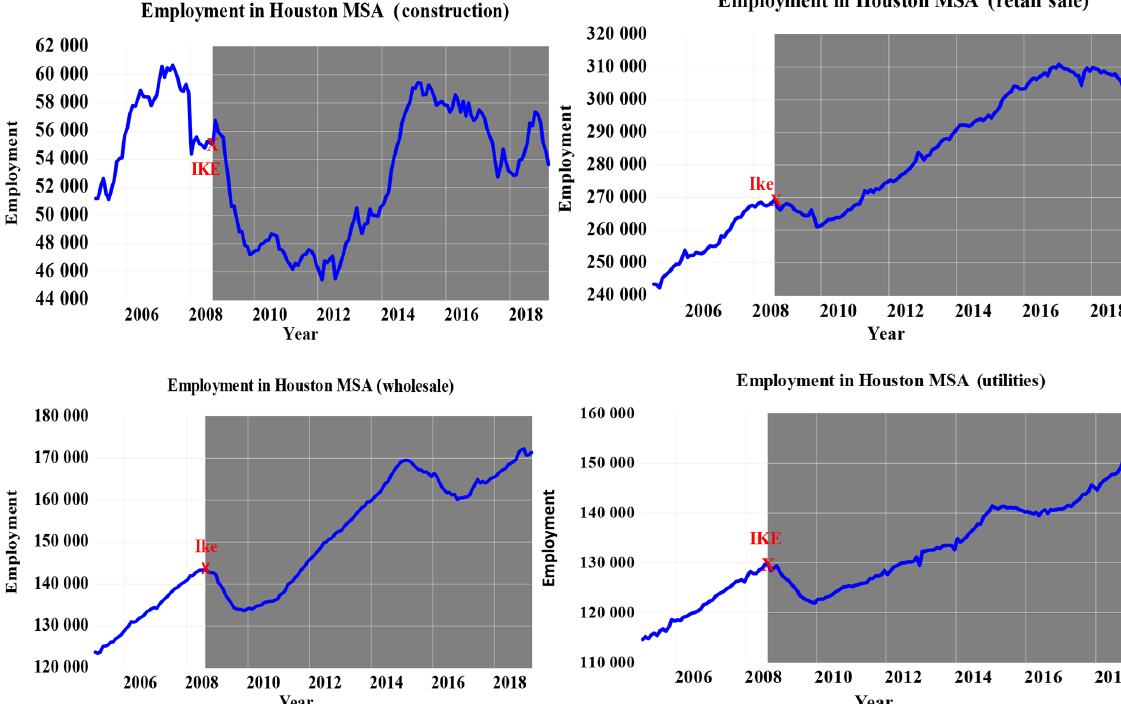
Figure 6. Monthly employment in four industries for Houston MSA.